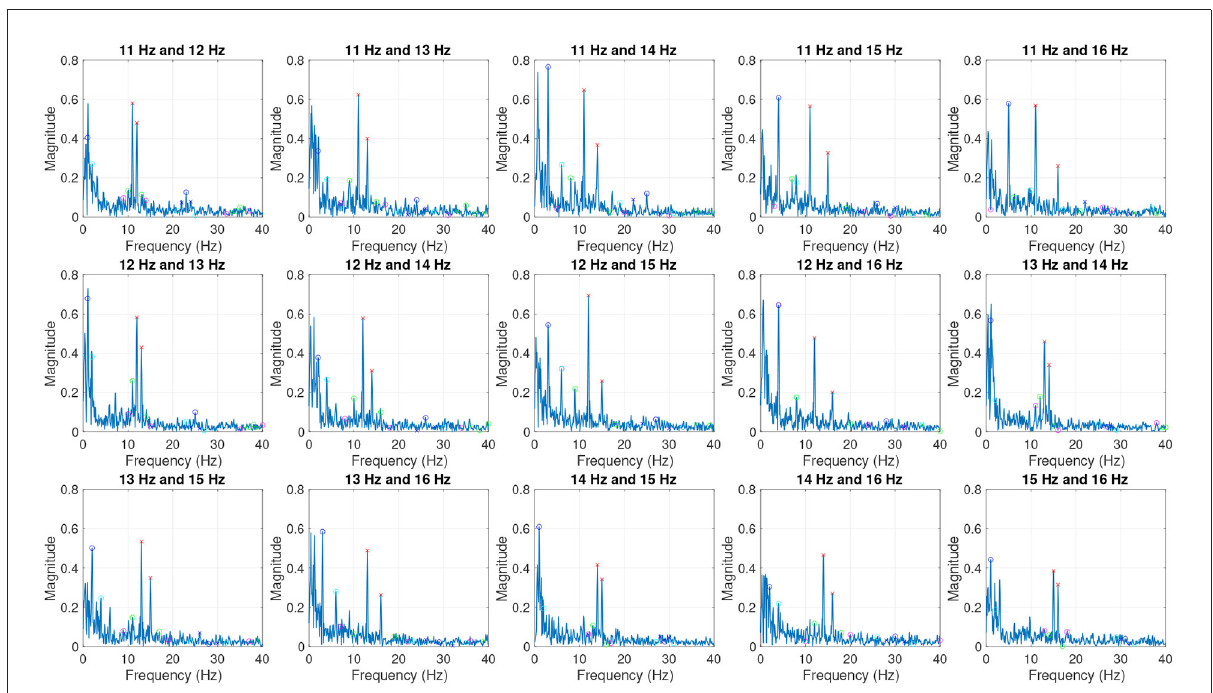
FIGURE5 Average SSVEP from Test 1 in frequency domain. Red crosses label the two stimulation frequencies. Crosses and circles indicate harmonics and linear combinations of the two frequencies, respectively. Orders N O are shown with different colors: red– N O = 1; blue– N O = 2; green– N O = 3; cyan– N O = 4; magenta– N O =